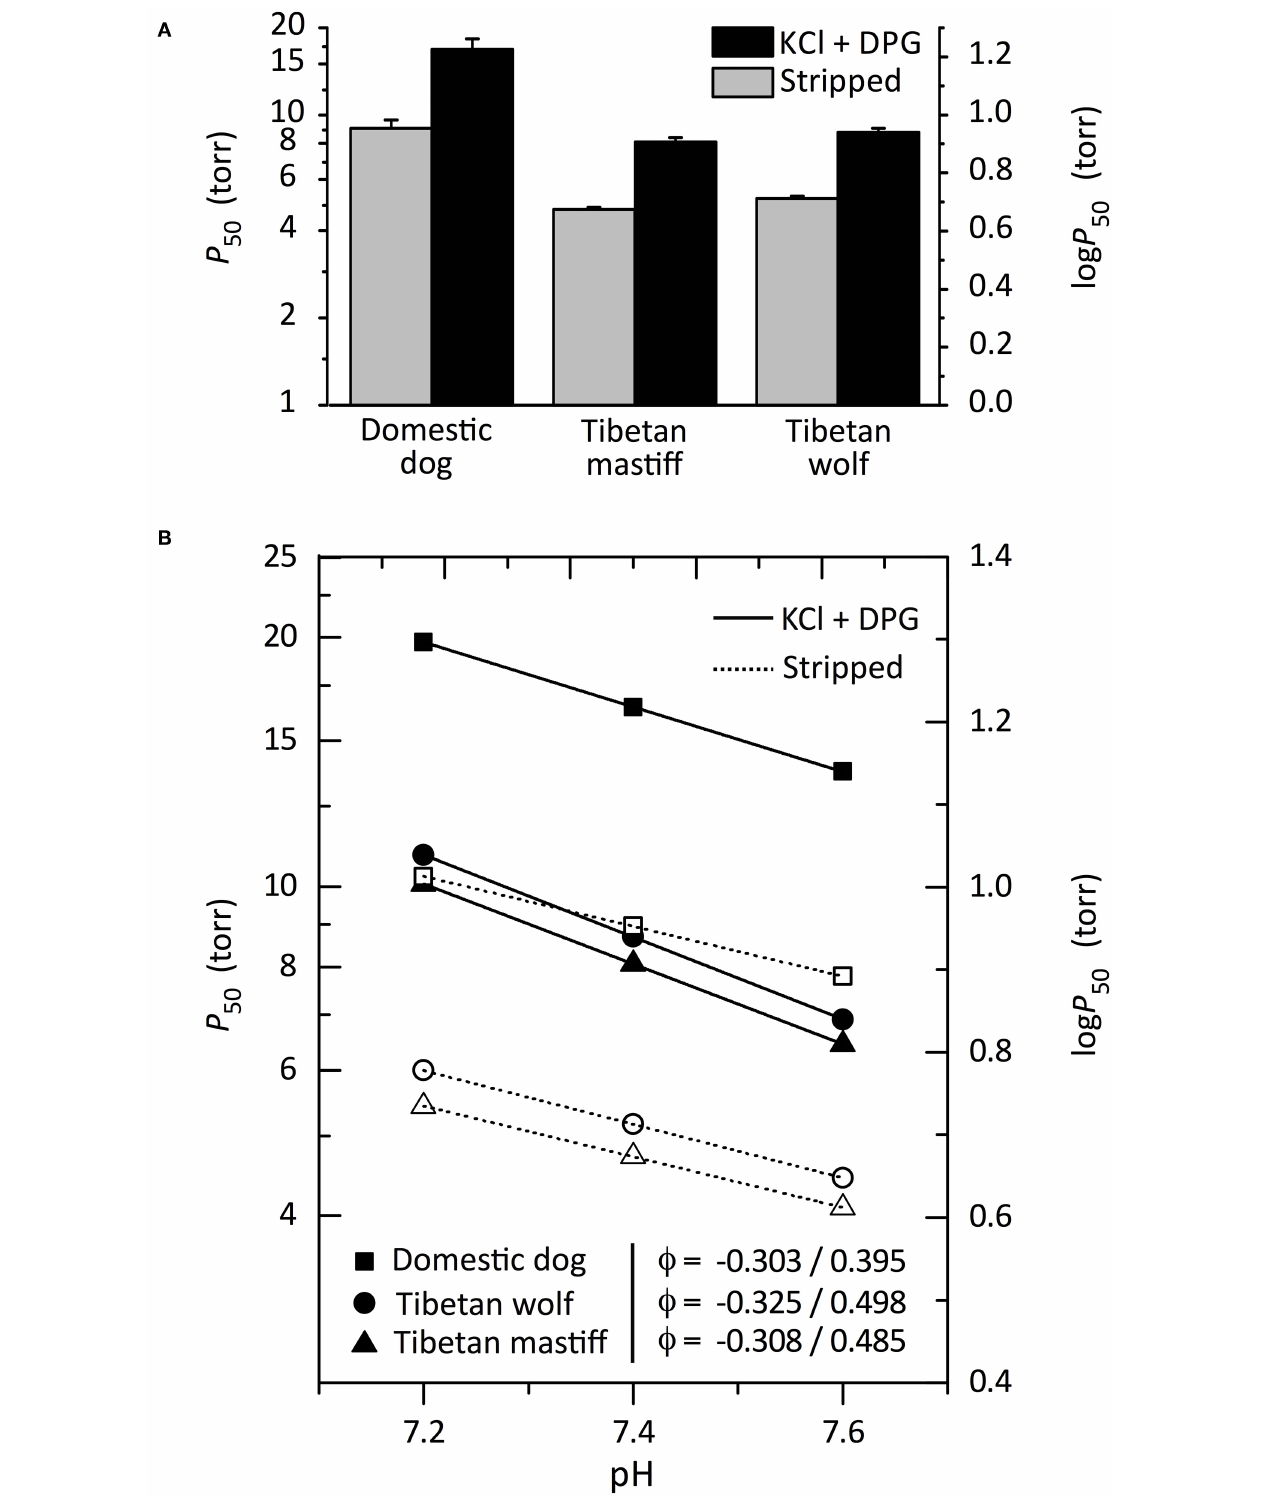
FIGURE 2 | Oxygenation properties of purified Hbs from Tibetan wolves, Tibetan mastiffs, and domestic dogs in the absence (“stripped”) and presence of allosteric cofactors [Cl − ions (KCl) and 2,3-diphosphoglycerate (DPG)]. (A) P 50 -values ( ± SEM), the P O 2 at 50% saturation, at 37 ◦ C, pH 7.4. The lower the P 50 , the higher the O 2 -affinity. (B) Bohr effect of canid Hbs, as indicated by a plot of log- P 50 vs. pH in the presence and absence of allosteric cofactors (filled and open symbols, respectively). Bohr coefficients ( ϕ ) are shown in the absence/presence of allosteric cofactors. Reproduced from Signore et al. (2019).